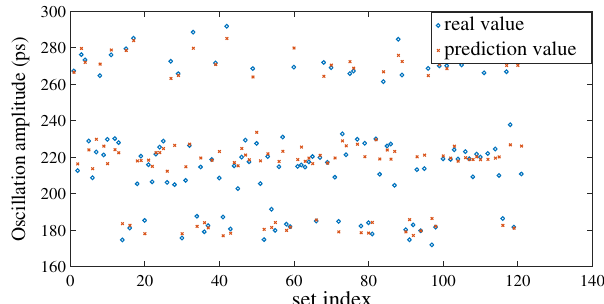
FIG. 5. Predictive value versus test value about oscillation amplitude. Blue mark: test value; orange mark: predictive